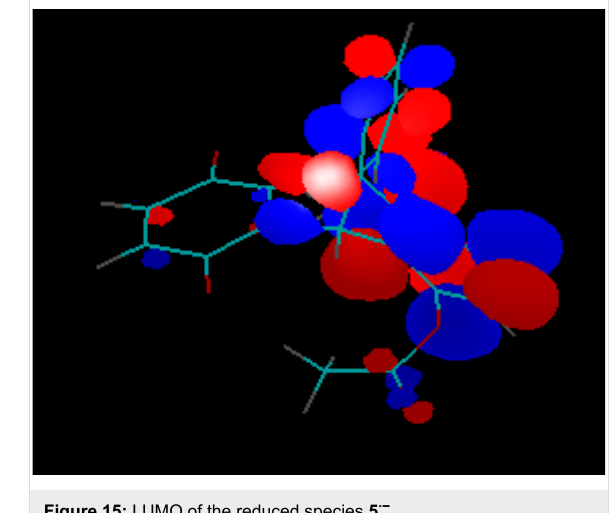
Figure 13: LUMO of Compound 5 .